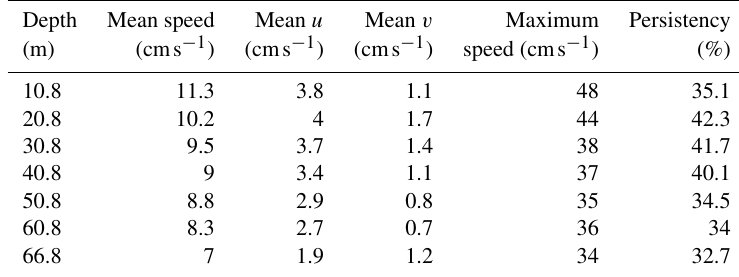
Table 1. Statistics of the 1h average ADCP current data from 28 February to 2 September